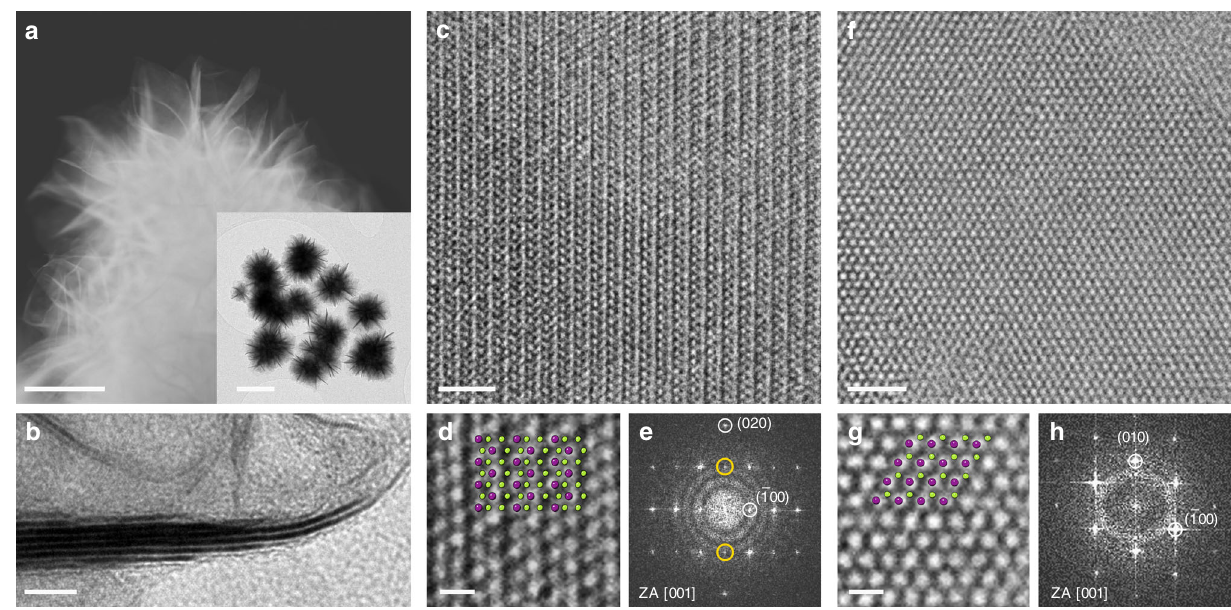
Fig. 1 Transmission electron microscopy (TEM) characterisation of the colloidal WSe 2 nanostructures. a Annular dark- fi eld scanning TEM image of a WSe 2 branched nano fl ower illustrating ultra-thin nature of individual nanosheets (scale bar: 100 nm), inset — an overview image of an ensemble of the WSe 2 nano fl owers (scale bar: 200 nm). b Side view TEM image of an individual petal thinning down to monolayer at the rim (scale bar: 5 nm). c High-resolution TEM image of the as-produced WSe 2 nanosheets demonstrating a continuous 1T ’ phase over a large area (scale bar: 2 nm); d zoomed in image (scale